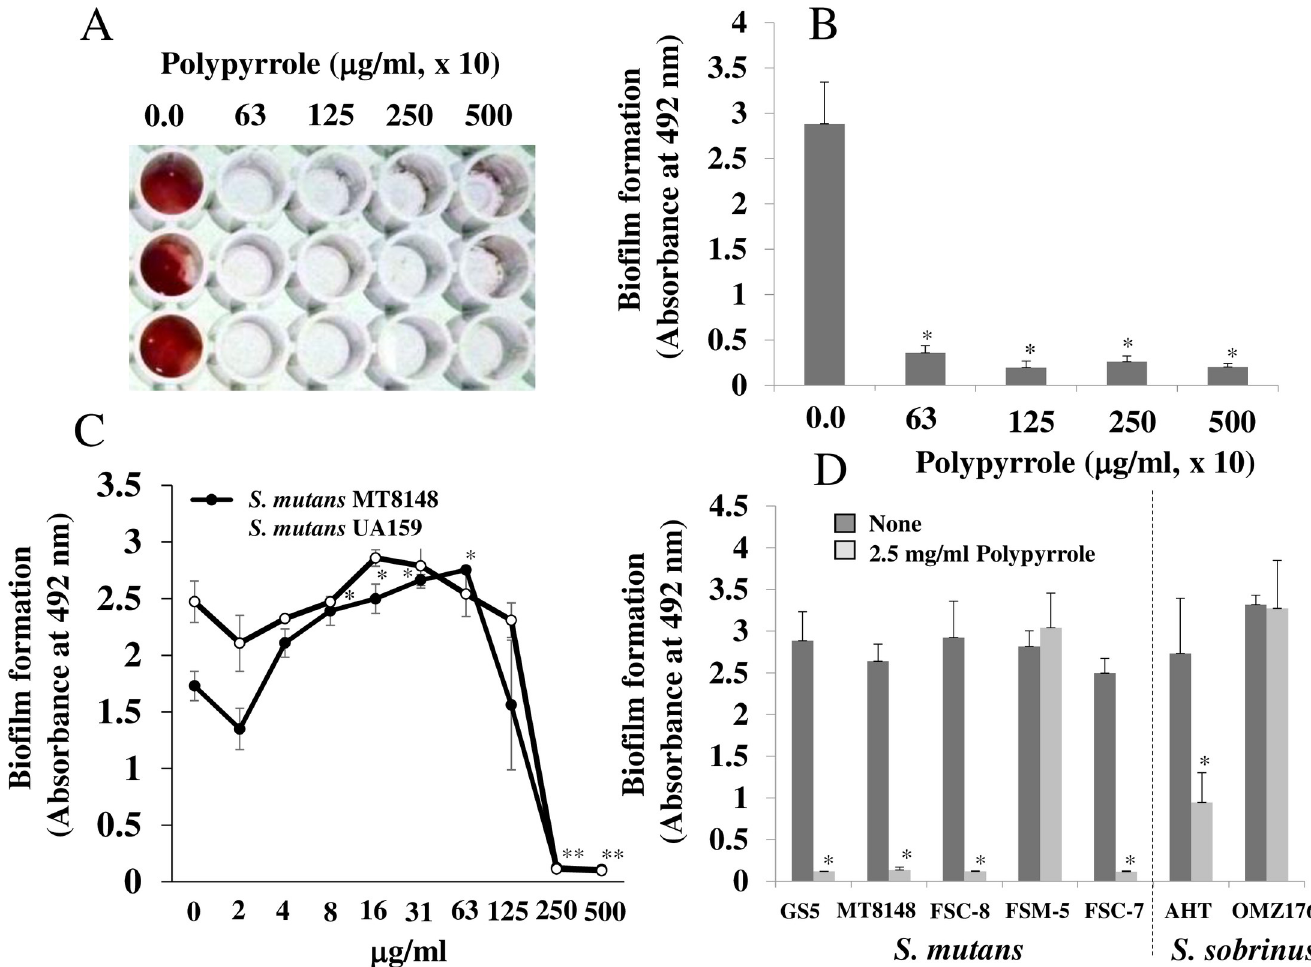
Fig 1. The inhibitory effects of polypyrrole on the biofilm formation of S . mutans . Effects of various concentrations of polypyrrole on the biofilm formation of S . mutans UA159 were observed on human saliva–coated 96-well microtiter plates after incubation for 16 h in TSB supplemented with 0.25% sucrose. A: Biofilm formation in S . mutans was present at high concentrations of polypyrrole (63, 125, 250 and 500 x 10 μ g/ml) on human saliva–coated 96-well microtiter plates. B: Biofilm formation in S . mutans UA159 was quantitatively analyzed at high concentrations of polypyrrole. C: Biofilm formation in S . mutans UA159 and MT8148 was quantitatively analyzed at various concentrations of polypyrrole. D: Biofilm formation in the S . mutans strains GS-5 and MT8148, clinical isolates FSC-8, FSM-5, and FSC-7, and S . sobrinus AHT and OMZ176 were quantitatively analyzed at 2.5 mg/ml polypyrrole. The data indicated the mean ± SD of triplicate experiments. The independent experiments were performed 3 times, with similar results obtained in each. The asterisks indicated a significant difference between 2 groups ( � : p < 0.05, no polypyrrole vs